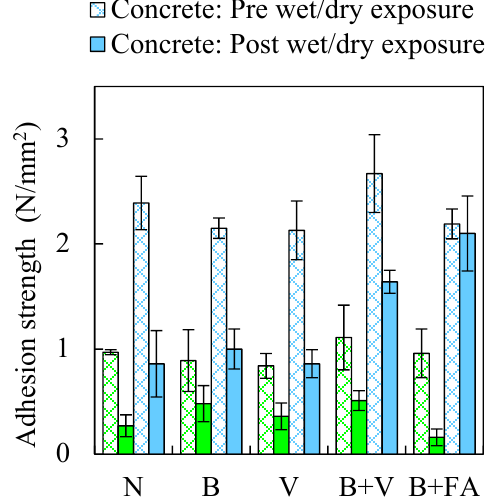
Figure 6. Adhesion strength between sprayed mor- tar and rock/concrete surfaces measured in spray test.